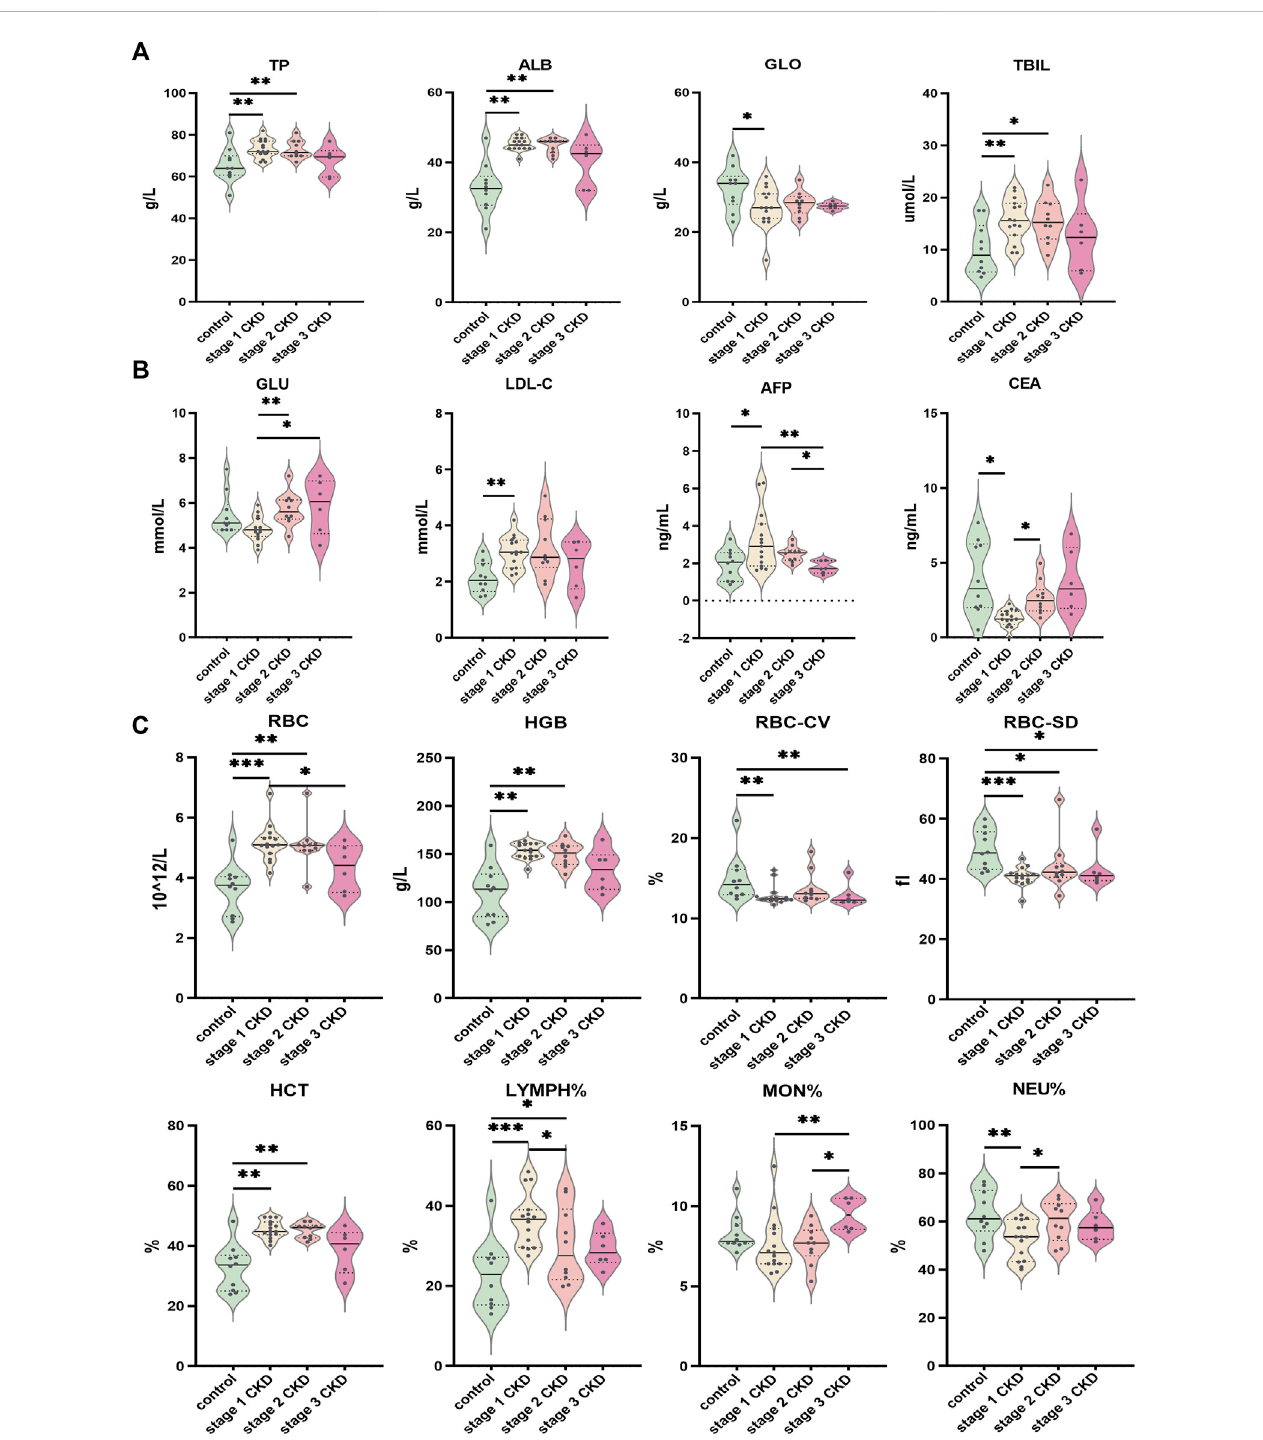
FIGURE 5 Comparison of clinical data of patients with different CKD stages with hyperuricemia and control group (A) Indices of liver function (TP, ALB, GLO, TBIL) for CKD at different stages; (B) Comparison of glucose and lipid metabolism (GLU, LDL-C) and tumor markers (AFP, CEA) in peripheral blood of different CKD stagescombinedwithHUAandcontrolgroup; (C) Comparisonofperipheralbloodroutineindices(RBC,HGB,RBC-CV,RBC-SD,HCT,LYMPH%,MON%,NEU %)indifferentstagesofCKD,combinedwithHUAandinthecontrolgroup.Thesolidlineinthepianochartisthemedian,andthedottedlineistheupper and lower quartiles, * p < 0.05, ** p < 0.01, *** p <